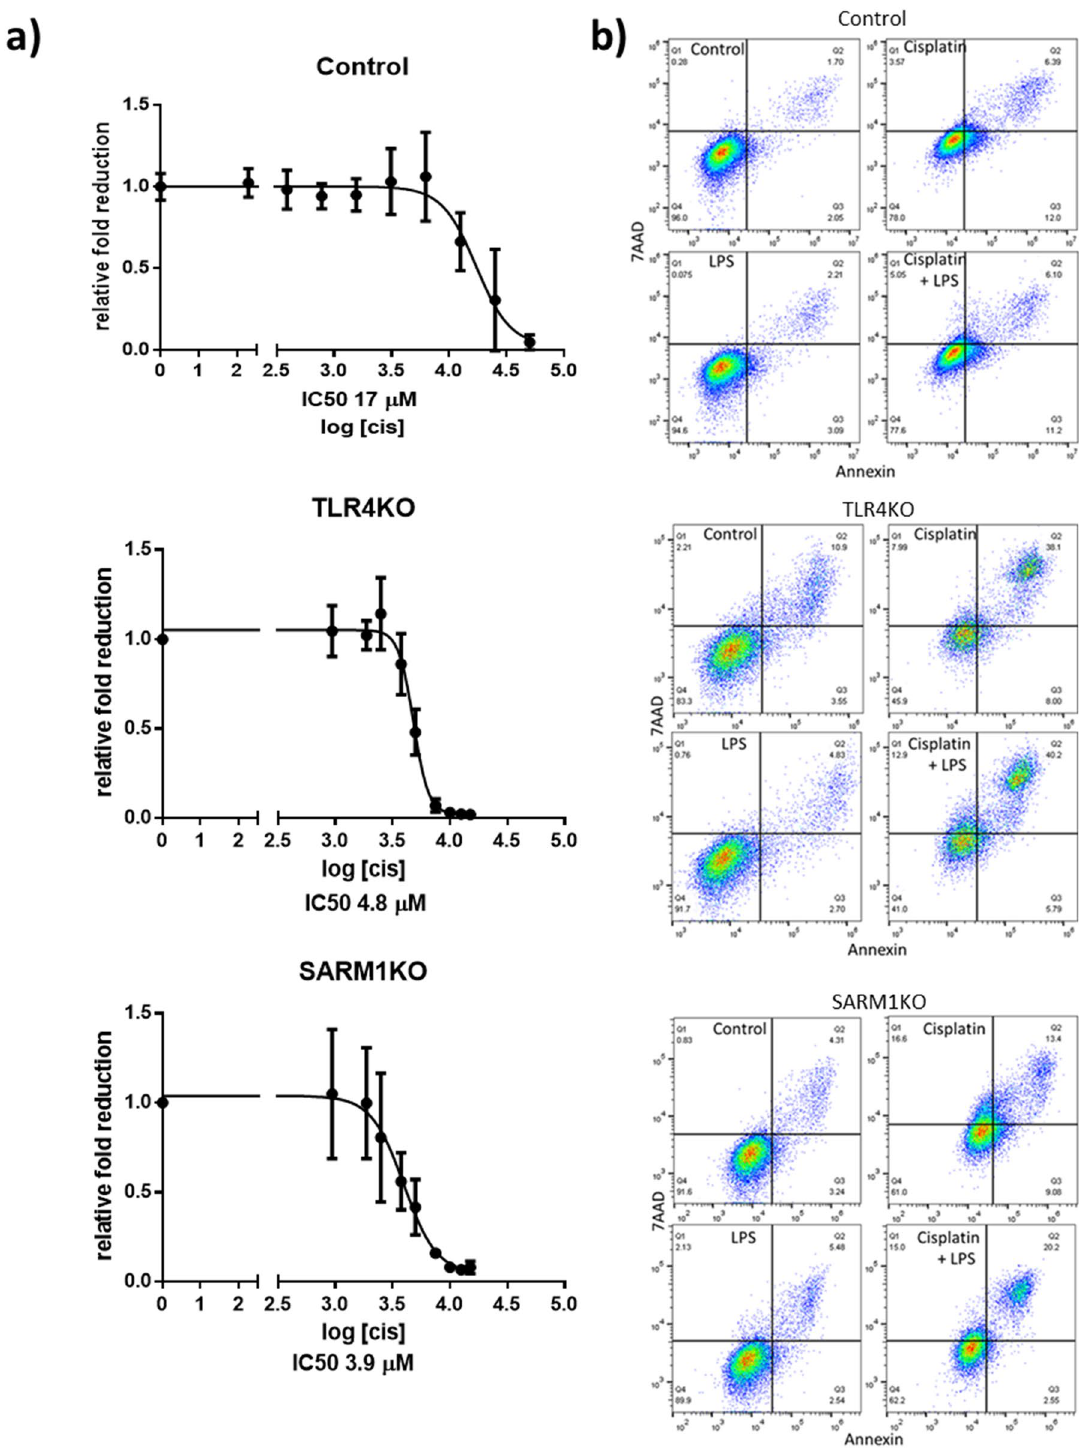
Figure 3. TLR4KO and SARM1KO cells are more sensitive to chemotherapy than parental HeLa cells. ( a ) Determination of half maximal inhibitory concentration (IC50) of cisplatin for TLR4KO, SARM1KO and parental HeLa cells. Cell viability was measured after 72 h of cisplatin treatment using PrestoBlue reagent assay. ( b ) Representative flow cytometry plots of apoptosis induced in parental unedited (top), TLR4KO (middle) and SARM1KO (bottom) cells after treatment with 4.7 µM cisplatin and/or 10 µg/mL LPS for 72 h, using 7-AAD and Annexin markers. Data in A displayed as mean ±